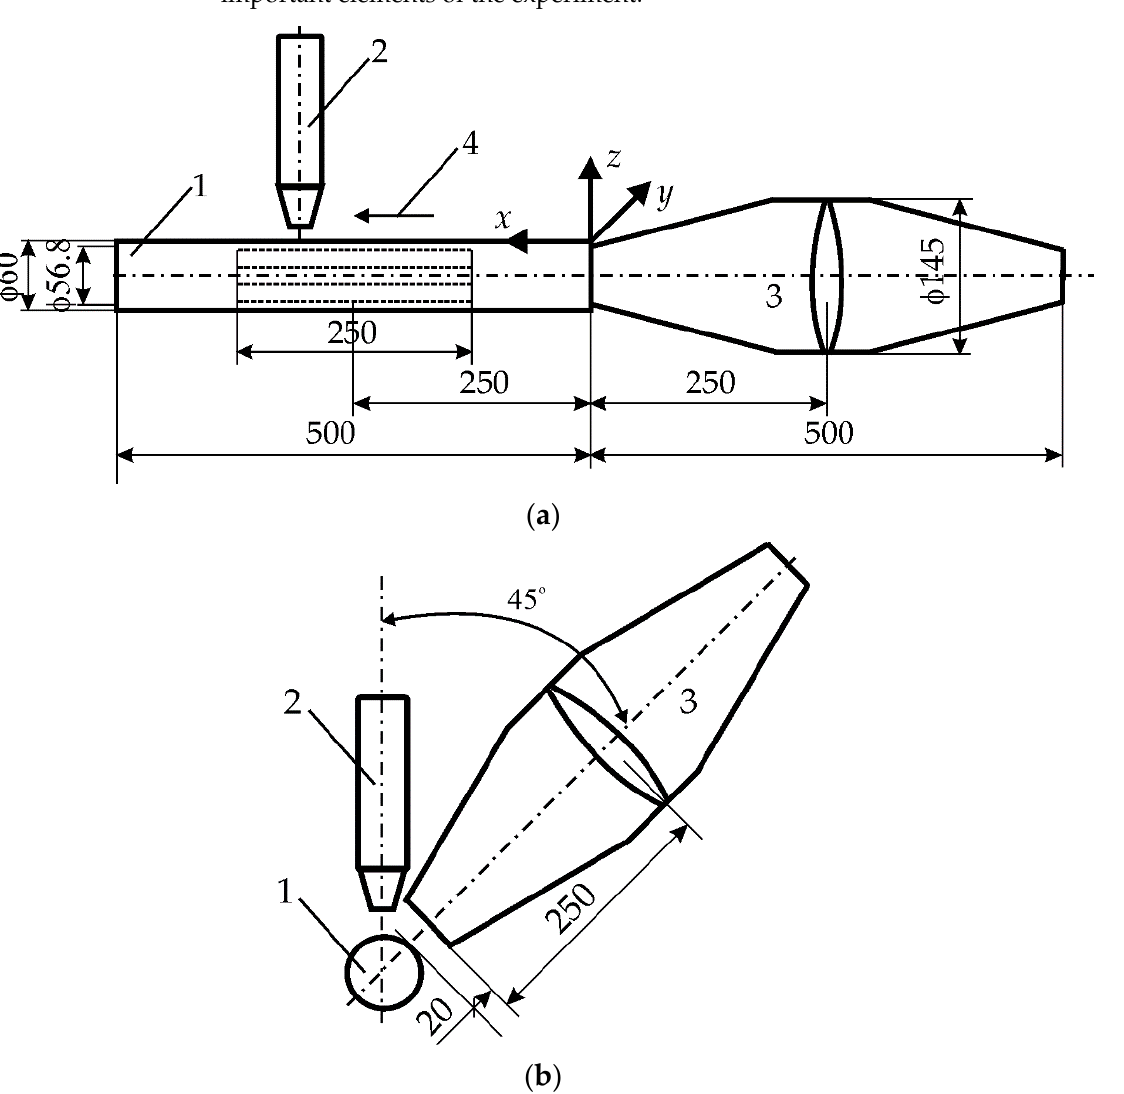
Figure 1. Experimental setup for the laser beam welding and introducing acoustic vibrations: ( a ) setting for the longitudinal introduction of vibrations, ( b ) setting for the transverse introduction of vibrations, 1—steel pipe, 2—CO 2 laser head, 3—source of acoustic vibrations, 4—direction of mov- ing heat source (all dimensions in mm).